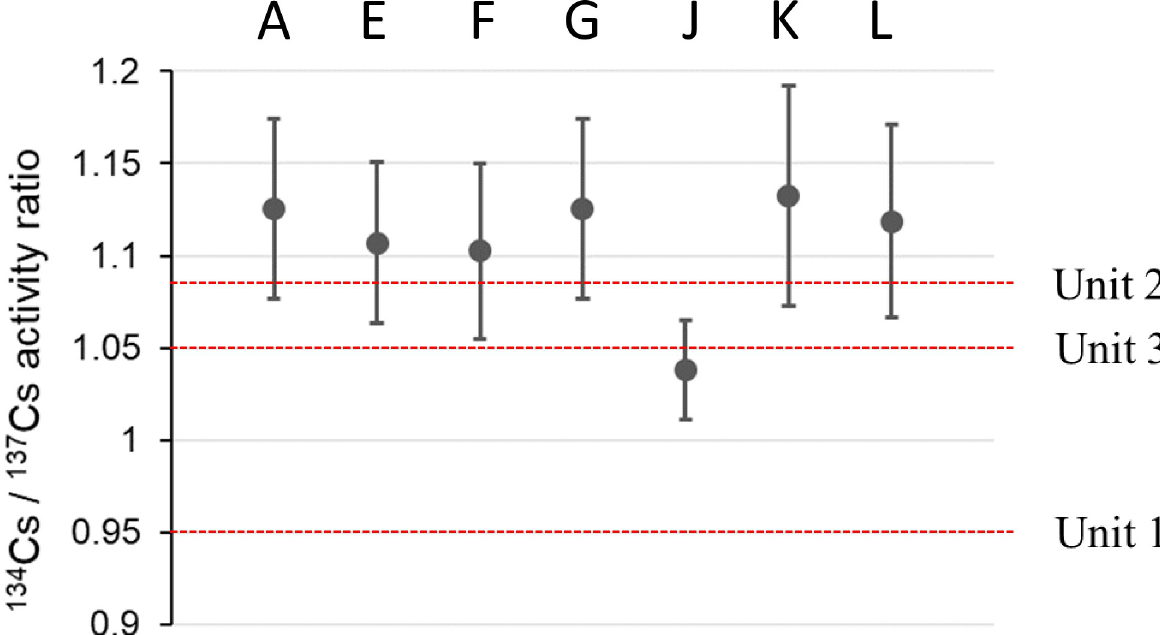
Fig 4. Cesium activity ratios ( 134 Cs / 137 Cs) of radiocesium-bearing microparticles (CsMPs). The letters A to L indicate the ID of the CsMPs (Table 2). The values of the damaged reactor cores (Units 1–3) are cited from Nishihara et al. [22].